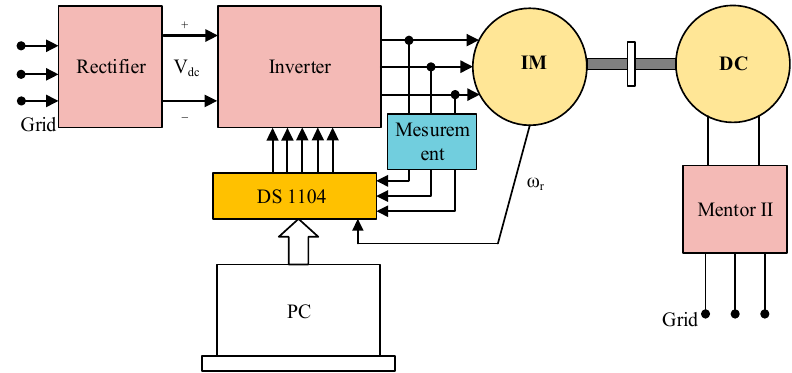
Figure 9. Experimental setup diagram.